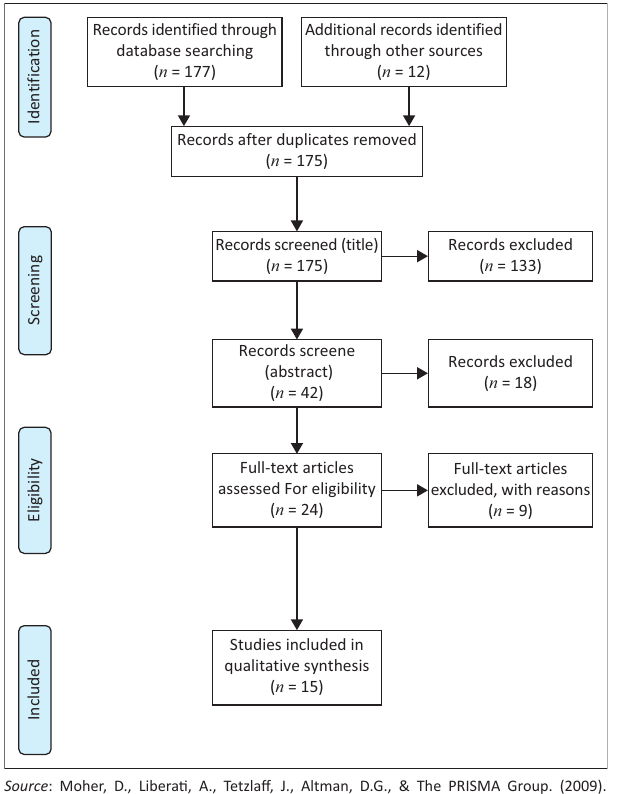
FIGURE 1: The PRISMA flow diagram describing the process of study